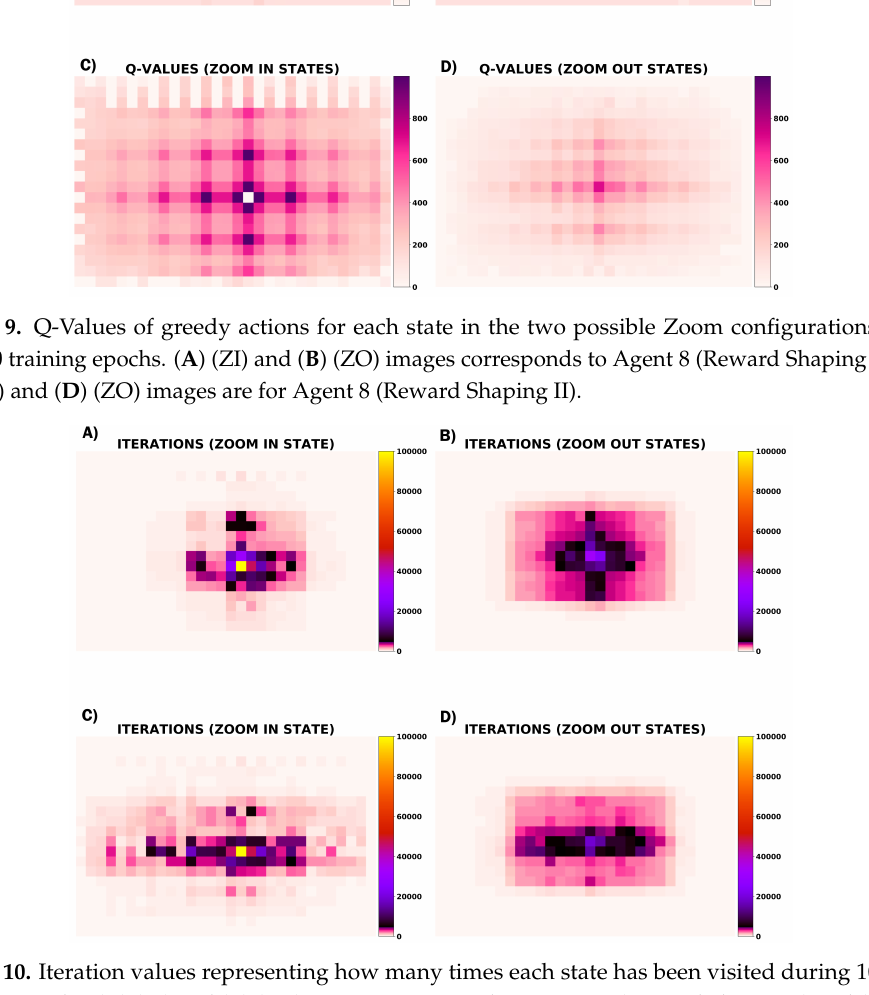
Figure 10. Iteration values representing how many times each state has been visited during 100,000 training epochs. ( A ) (ZI) and ( B ) (ZO) images corresponds to Agent 8 (Reward Shaping I) and ( C ) (ZI) and ( D ) (ZO) images are for Agent 8 (Reward Shaping